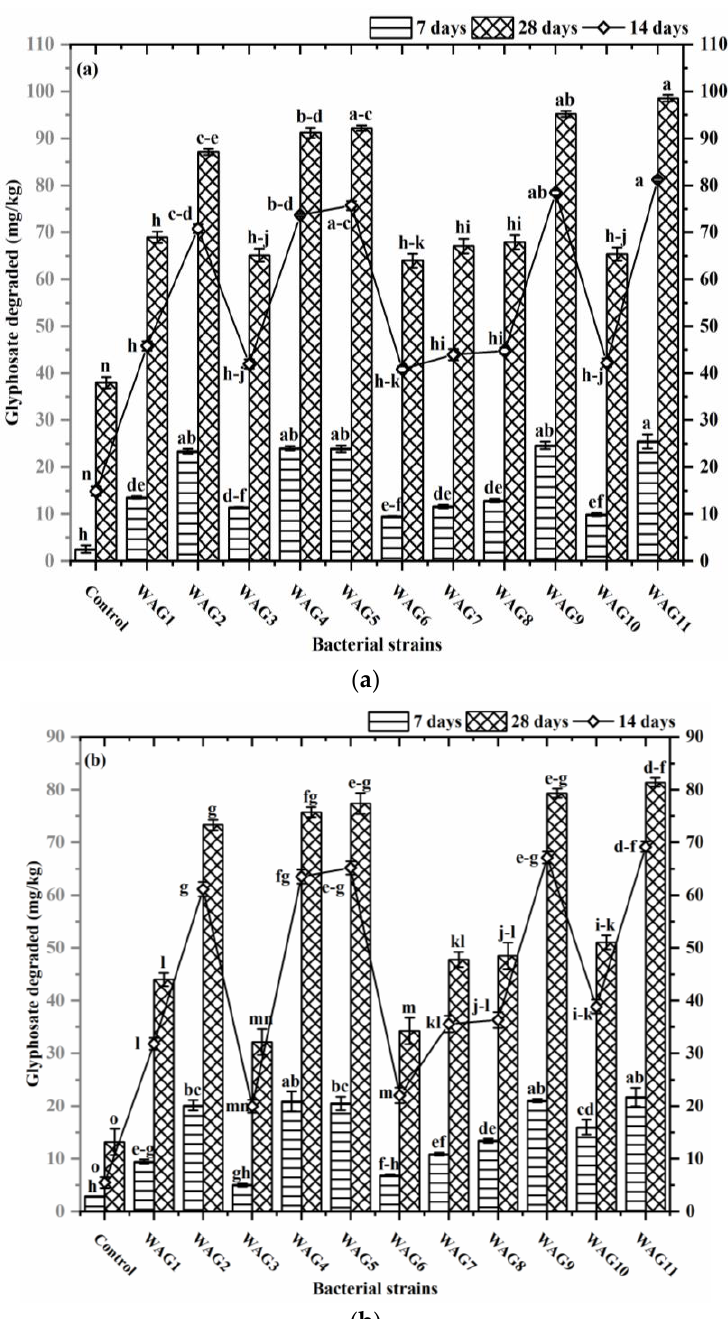
Figure 1. Removal of glyphosate by eleven isolated bacteria in autoclaved sand containing 100 mg/kg glyphosate ( a ) and 200 mg kg glyphosate ( b ) at 7, 14, and 28 days, respectively. The control contained the same culture medium without bacterial inoculation. Results represent the mean value of three replicates and error bars indicate the standard deviations. Treatment means sharing the same letter(s) do not differ significantly at p < 0.05.